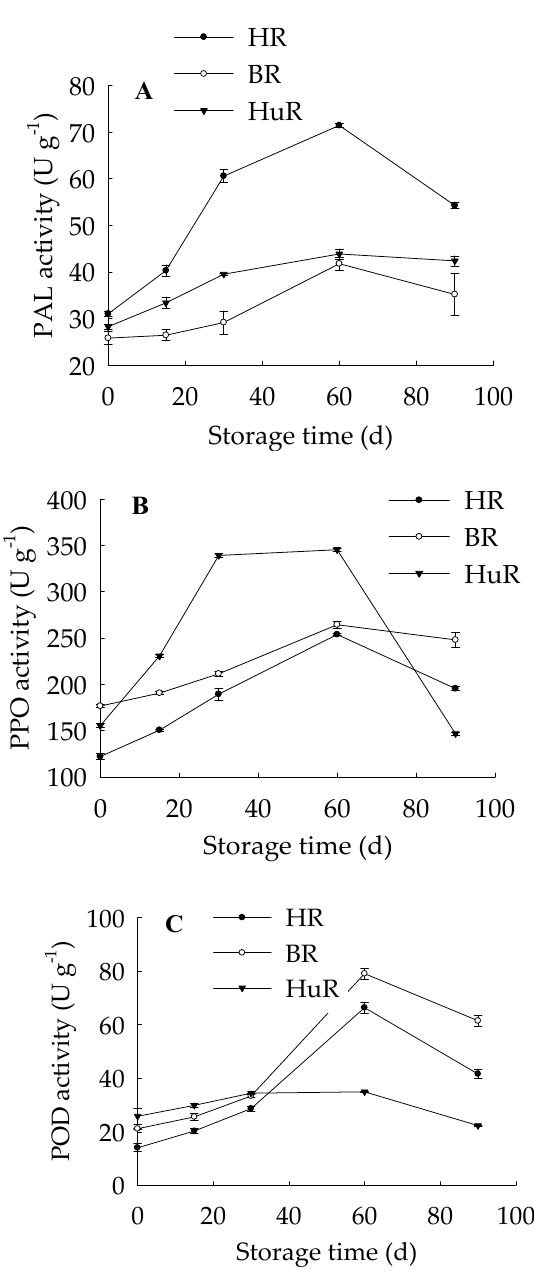
Figure 5. Changes in PAL ( A ), PPO ( B ), POD ( C ) activities in juice sacs of three pumelo cultivars. Vertical bars represent SE of the means of three replicate assays.